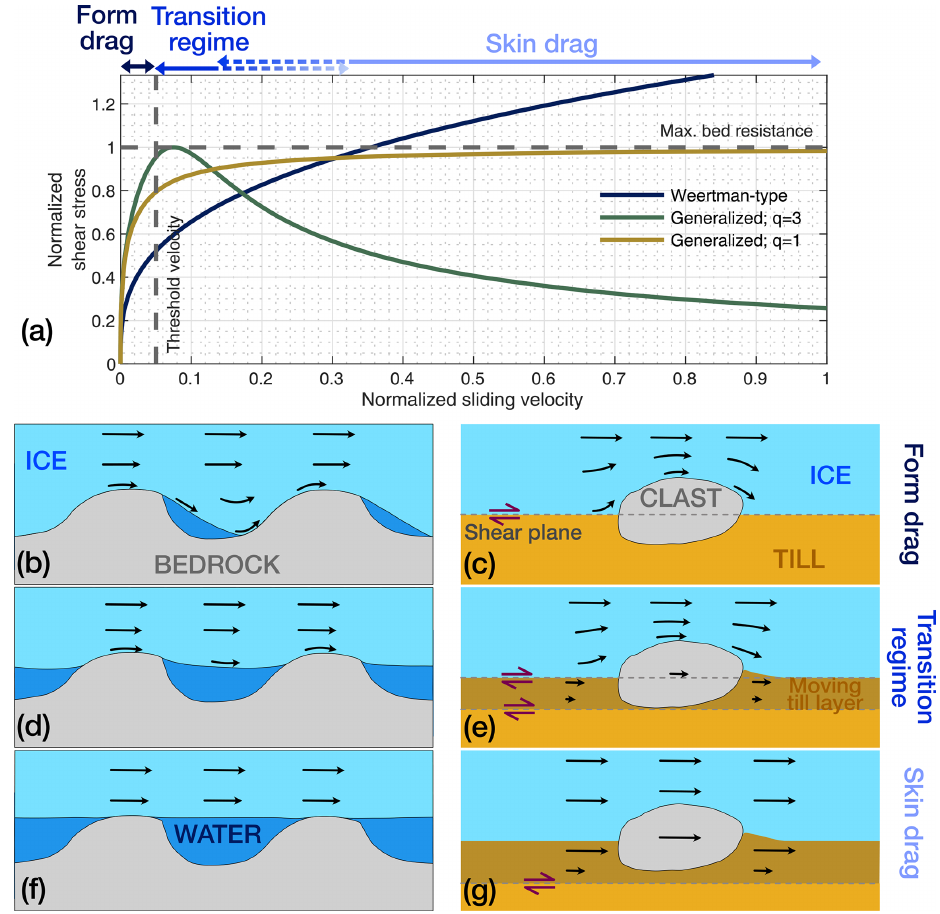
Figure 1. Conceptual representation of glacier sliding relationships for rigid and deformable beds, inspired by Minchew and Joughin (2020). Plot of normalized shear stress versus normalized sliding velocity, comparing Weertman-type sliding and two forms of the generalized sliding relationship (a) . Schematic representation of form drag (b, c) , transition regime (d, e) , and skin drag (f, g) for a rigid bedrock bed (b, d, f) and for a deformable till bed (c, e, g) . We use form drag to describe the macroscopic viscous drag on bed obstacles and skin drag to describe the viscous drag at the scale of the boundary layer between the ice (fluid) and bed. The transition regime depends on the bed characteristics (in particular q ), and the shift to skin drag can be arbitrary. It is different for each relationship plotted, hence the dashed lines showing the possible overlap. For a rigid bed, the skin friction regime can be likened to a curling stone sliding on an ice track, while it represents Coulomb failure for a deformable bed. Note that the shear stress is normalized by an imposed σ max = 150 × kPa, and the sliding velocity normalized arbitrarily by 40md − 1 , u t = 2md − 1 , and p = 3. For the Weertman-type relationship, we use τ b = (u b N/C s ) 1 /p , with N ≈ 600 × kPa, and C s = 2 . 5 × 10 − 9 ma − 1 Pa − p